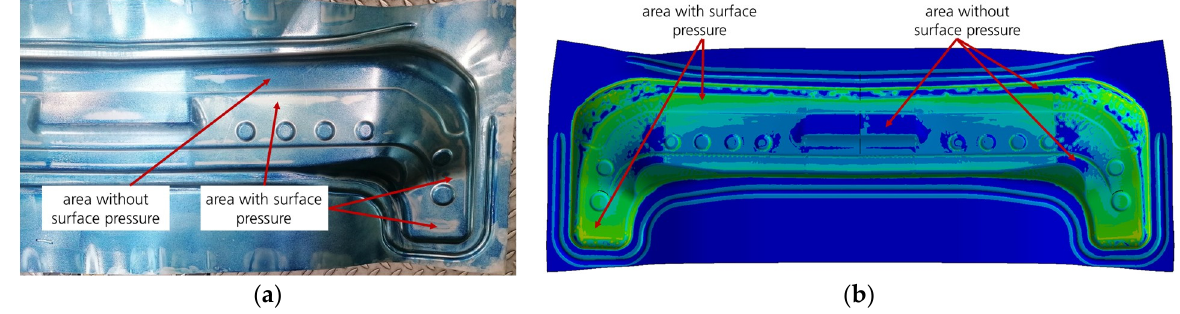
Figure 8. Comparison of ( a ) real and ( b ) virtual spotting pattern including elasticity of press, sheet thinning, and refined tool geometry.